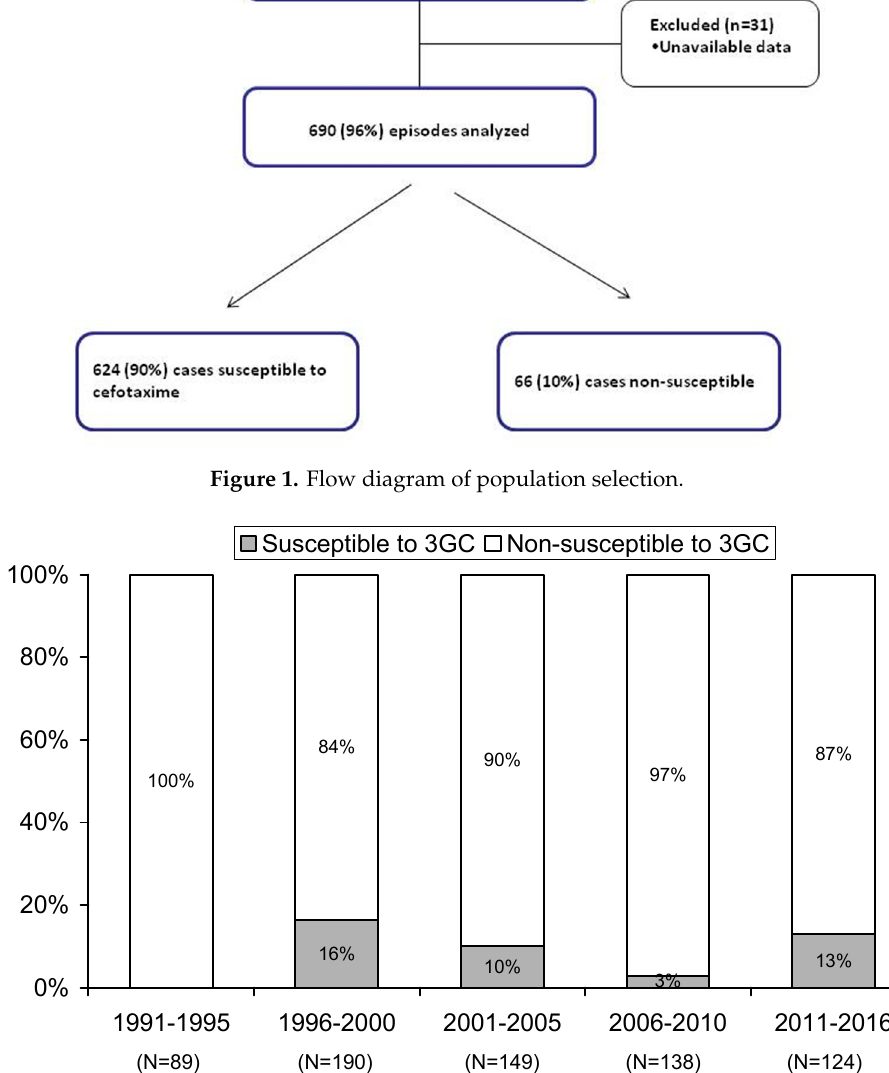
Figure 1. Flow diagram of population selection.